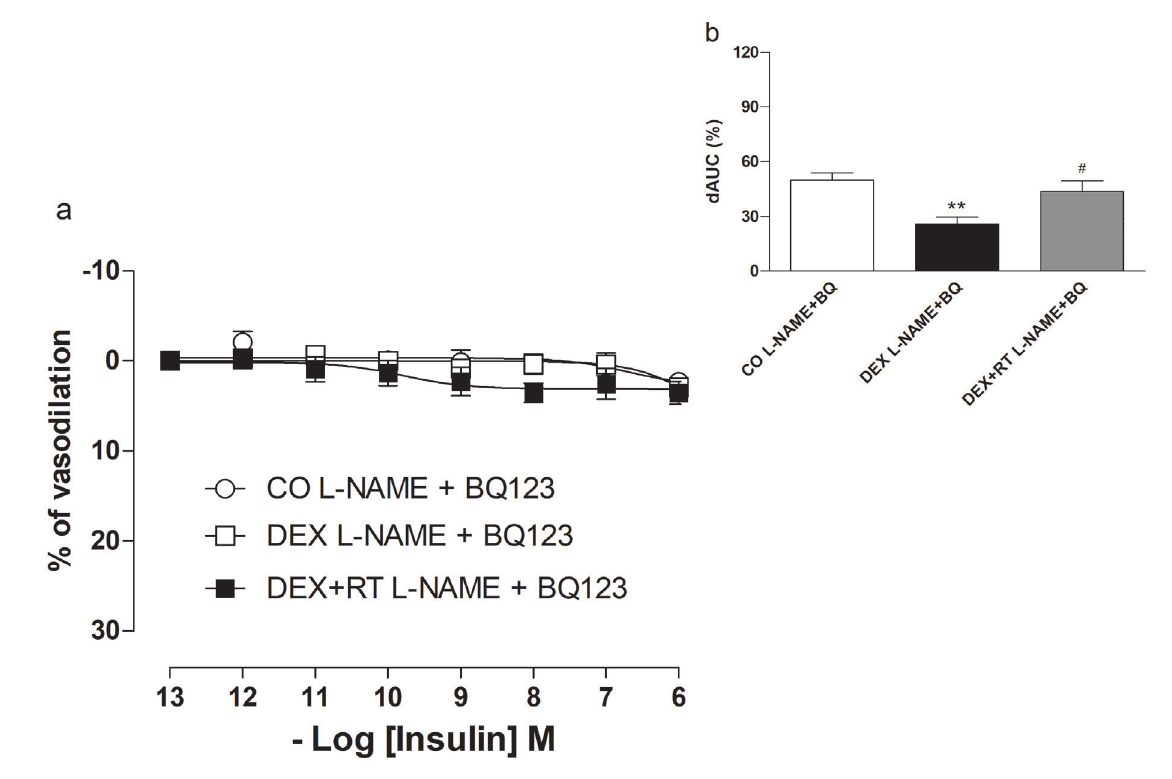
Figure 4. Cumulative concentration-response curve to insulin in intact segments obtained from the superior mesenteric artery of Wistar rats and pre-contracted with phenylephrine (1 μM) in the control (CO), dexamethasone-treated (DEX) and dexamethasone + resistance training (DEX+RT) groups, in the presence of L-NAME + BQ123 (100 μM and 1 μM, respectively) (a), and the difference in the area under the concentration– response curve (dAUC) for the response to insulin is shown for the CO, DEX and DEX+RT groups (b). The results are expressed as the mean ± SEM for 8–10 experiments in each group. *p< 0.01, CO vs. DEX; # p< 0.05, DEX vs.